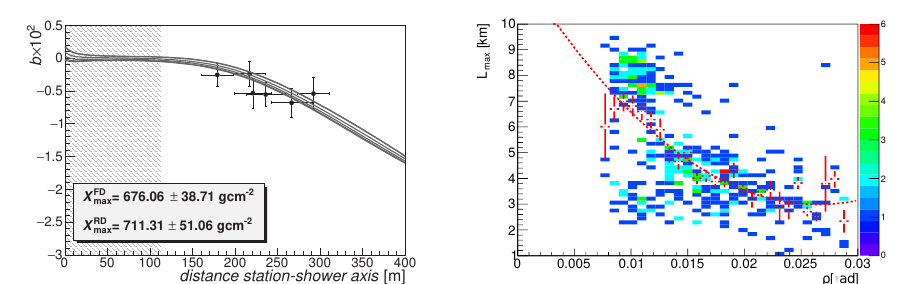
Figure 2 . Left: Spectral index b as a function of the distance antenna-shower axis for an AERA event Figure 1 . Distribution of the radio signal for an AERA event. The background color map shows the with 6 signal stations. The grey lines are the best predictions obtained using X max measured by the values of the function that is fitted to the d ata: subtraction of two Gaussian distributions (left) and FD. In the hatched areas the parametrization of the spectral index is not valid. Right: Distance L max to emission mechanisms parameterization (right). In the two plots it is visible the radial asymmetry the shower maximum as a function of the cone opening angle ρ for the simulated dataset. The dashed created by the superposition of the two emission mechanisms. The circles represent the antennas, the line is the polynomial function fitted on the profile distribution color inside the station is the detected energy density. When the color inside the circles matches the background the fit is successful. In both cases the resulting X RD max is compatible with the corresponding fluorescence telescopes measurement ( X FD max ).